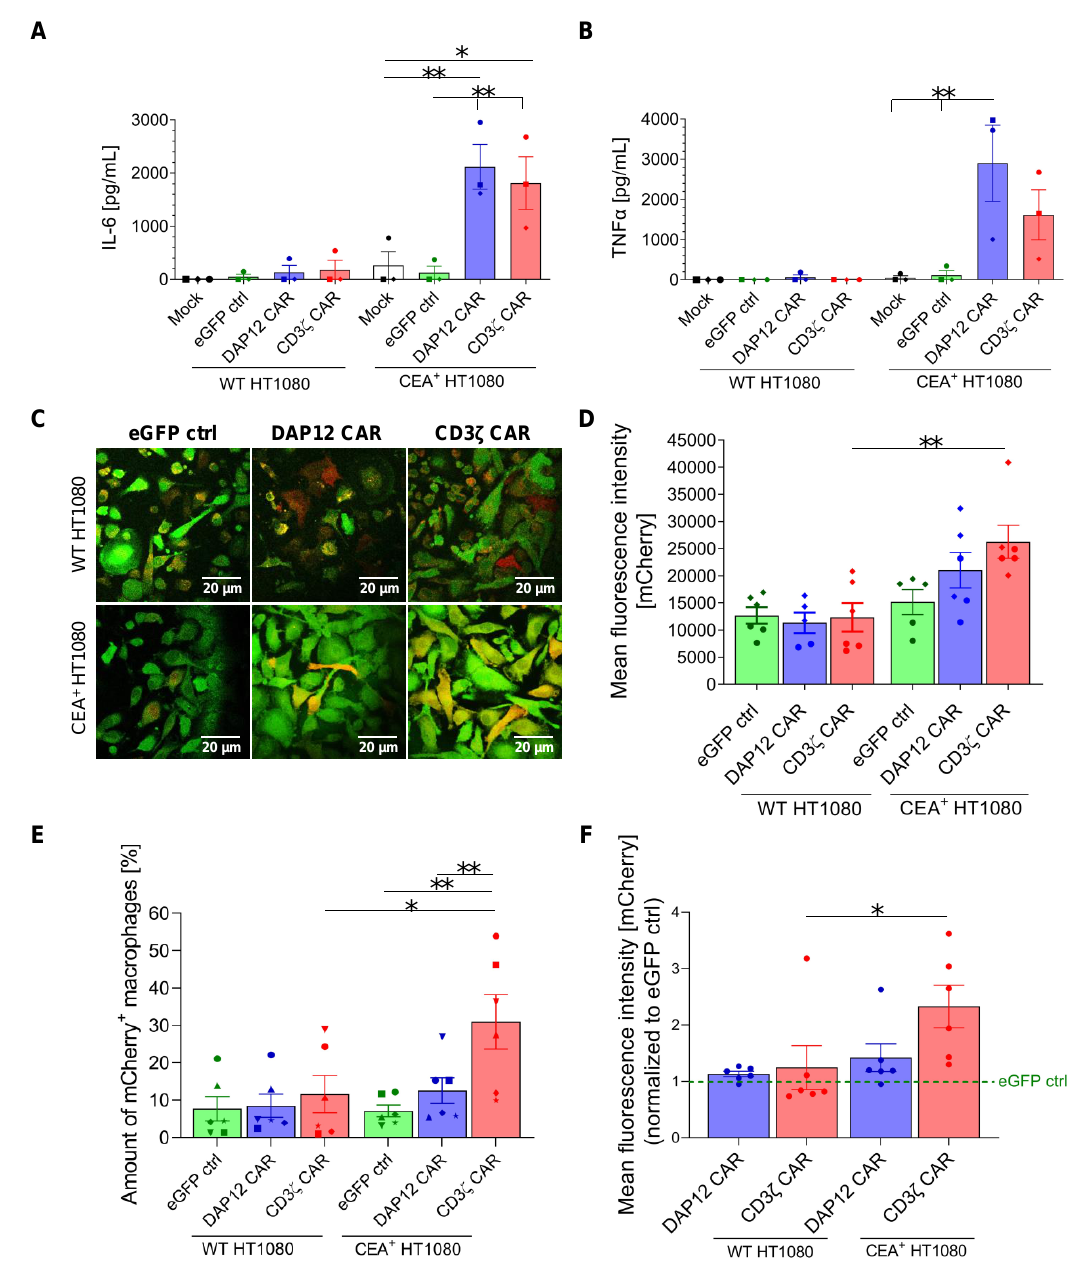
Figure 5. CAR-mediated cytokine secretion and phagocytosis after co-culture of M Φ s with WT/mCherry + or CEA + /mCherry + HT1080 target cells. ( A ) IL-6 and ( B ) TNF α secretion in M Φ s after co-culture with WT/mCherry + or CEA + /mCherry + HT1080 cells. Data are represented as the mean ± s.e.m. of n = 3 biological replicates. Statistical significance was calculated with one-way ANOVA using multiple comparisons. ( C ) Confocal microscopy images showing phagocytosis of WT/mCherry + or CEA + /mCherry + HT1080 cells (mCherry) by CAR M Φ s (eGFP) (63 × oil immer- sion objective of the Leica DMi8 confocal microscope, scale bar: 20 µ m). Images are shown for a representative out of 2 experiments. ( D ) Analysis of confocal images depicted via the geometric mean of mCherry signal intensity inside the M Φ s. Data are represented as the mean ± s.e.m. of n = 2 biological replicates, with 2-3 random fields of view analyzed per replicate. Flow cytometric analysis of ( E ) % of mCherry + M Φ s and ( F ) geometric mean of mCherry signal intensity of eGFP + M Φ s after co-culture with target cells. Data are represented as the mean ± s.e.m. of n = 6 biological replicates. Statistical significance was calculated with one-way ANOVA using multiple comparisons. ** indicates p < 0.01, and * indicates p < 0.03. Mock: untransduced CD34-derived M Φ s; ctrl: